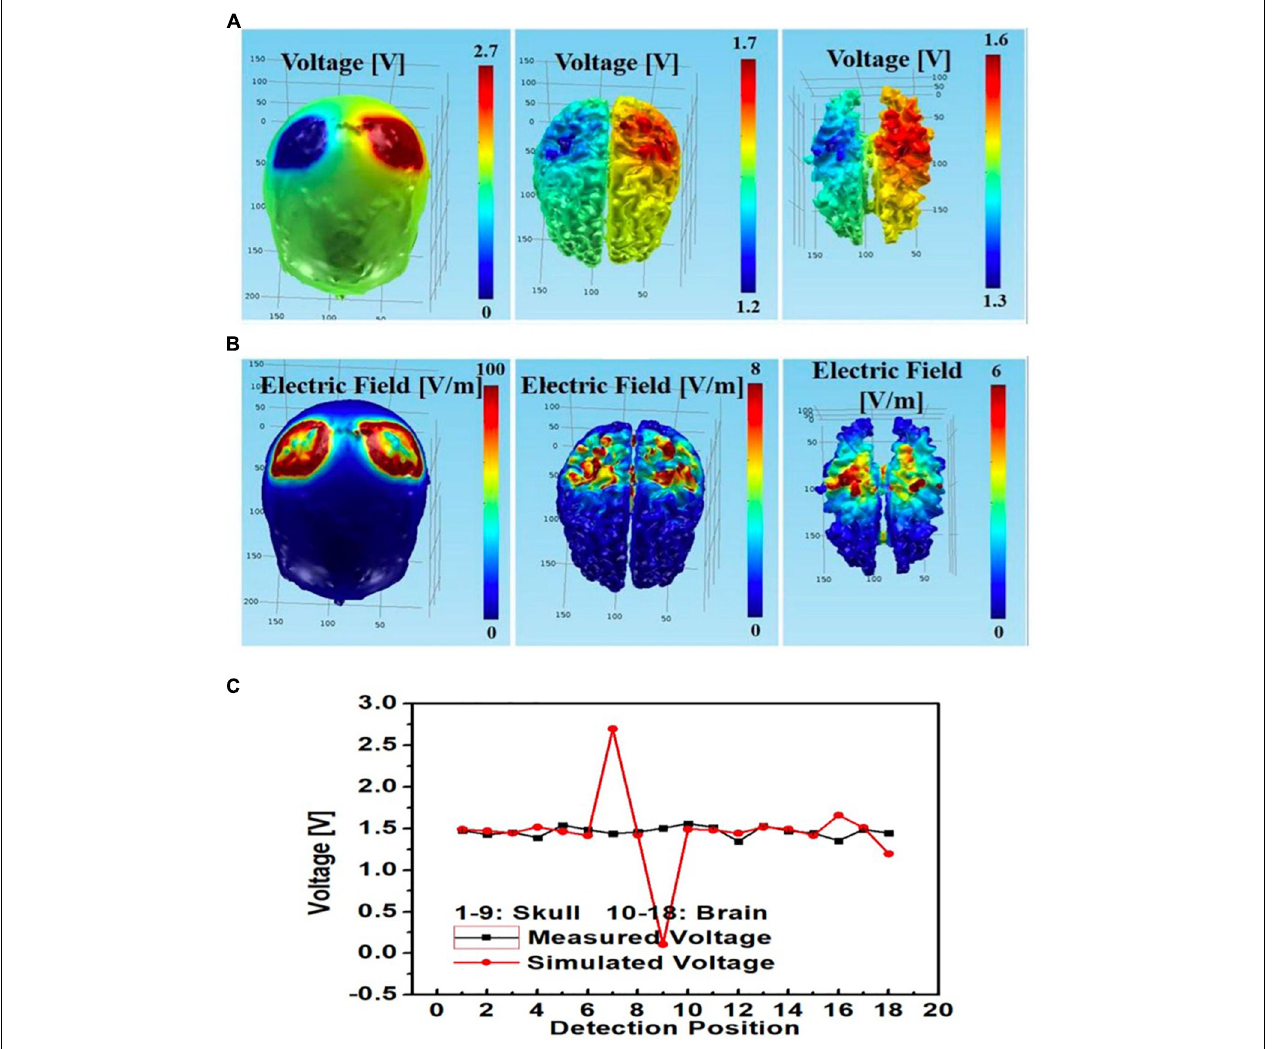
FIGURE 12 | Bilateral PMC montage with left PMC anode and right PMC cathode using circular star array electrodes for stimulation; simulated (A) electric potential and (B) electric field in skull (left), gray matter (middle) and white matter (right); (C) simulated and measured voltages at the 9 monitoring electrodes in the skull and brain layers.